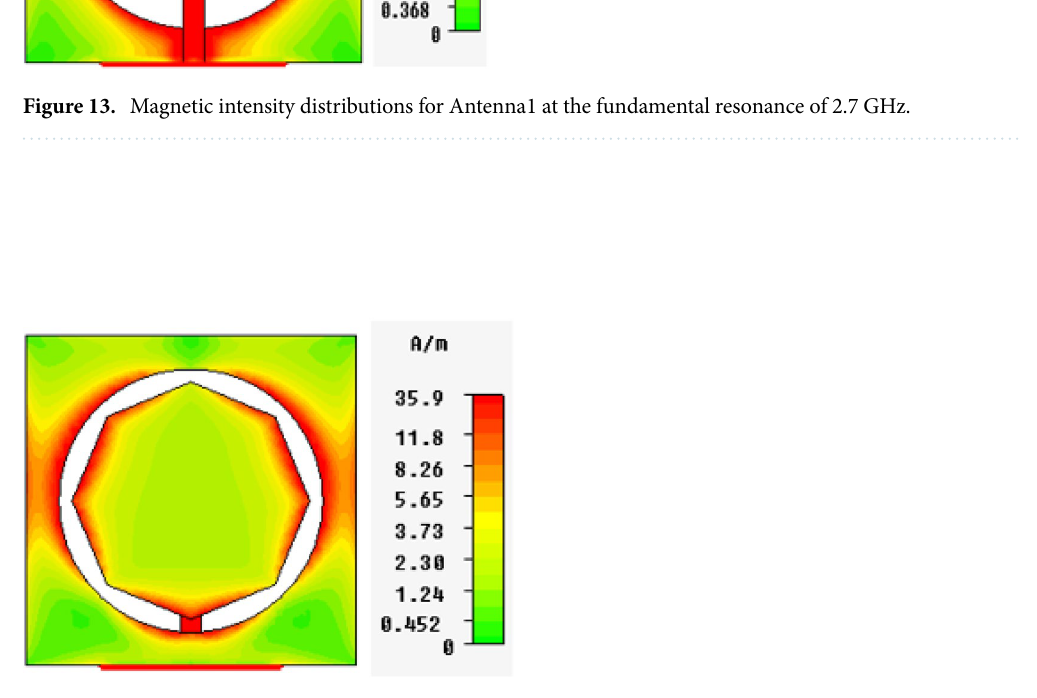
Figure 14. Magnetic intensity distributions for Antenna2 at the fundamental resonance of 2.55